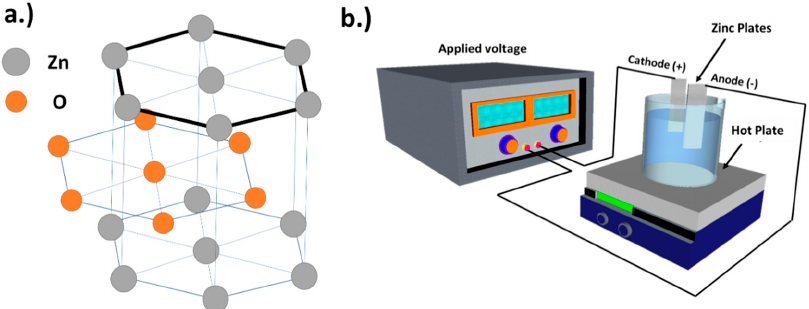
Figure 1. Illustration of ( a ) crystal structure of ZnO highlighting the (0001) plane; and ( b ) electrochemical setup used in this work.